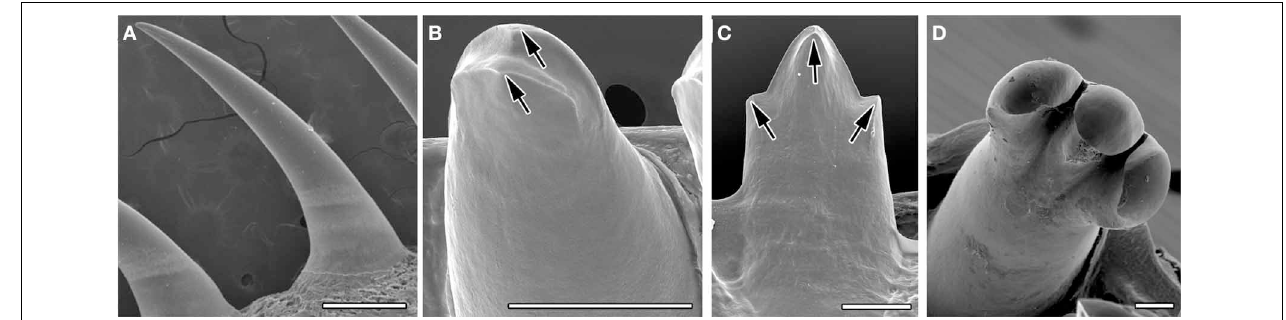
FIGURE 1 | Tooth crown variety in reptiles. SEMs of adult teeth. (A) Unicuspid snake, Python molurus , (B) two crests in gecko, Paroedura picta , arrowed. (C) Tricuspid anole, Anolis allisoni . Cusps arrowed. (D) Tricuspid Monitor lizard, Varanus niloticus. Scale bar = 500 µ m (A) and 100 µ m (B–D)